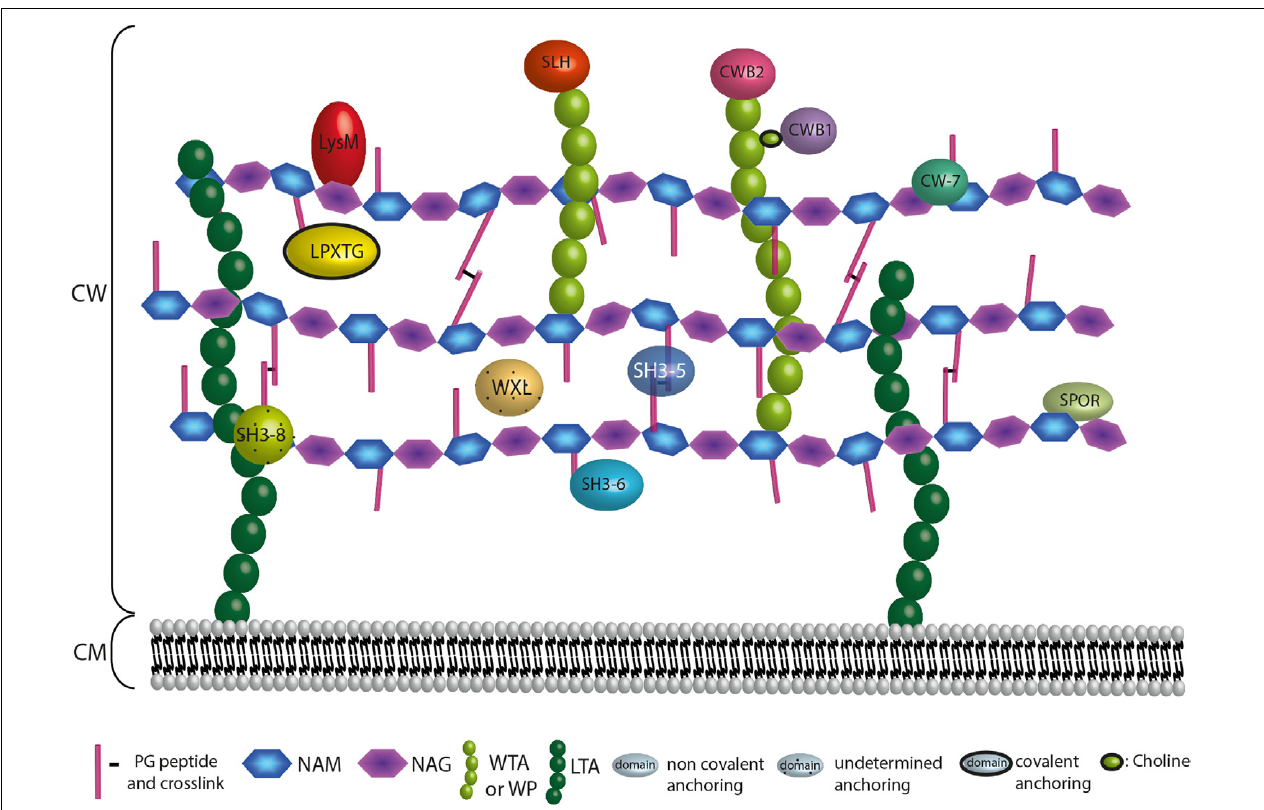
FIGURE 6 | Anchoring localization of protein domains interacting with the CW. The localization of the CW proteins depends on their domains. Domains are interacting covalently or not at the bacterial CW through interaction with surface structures that are the PG, the WTAs, the WPs or the LTAs. LPXTG proteins are covalently attached to the A2pm or K residue of the PG. Proteins harbouring a LysM, SH3 of type 5 (SH3-5), SH3 of type 6 (SH3-6), SPOR, or CW-7 domain interact non-covalently with the PG. WXL interacts with PG but the precise anchoring region is undetermined. Proteins possessing a CWB2 or SLH domain are localised at the WTAs or WPs extremities, whereas proteins harbouring a CWB1 domain interact with the WTAs through a choline. For SH3 of type 8 (SH3-8), the CW target remains